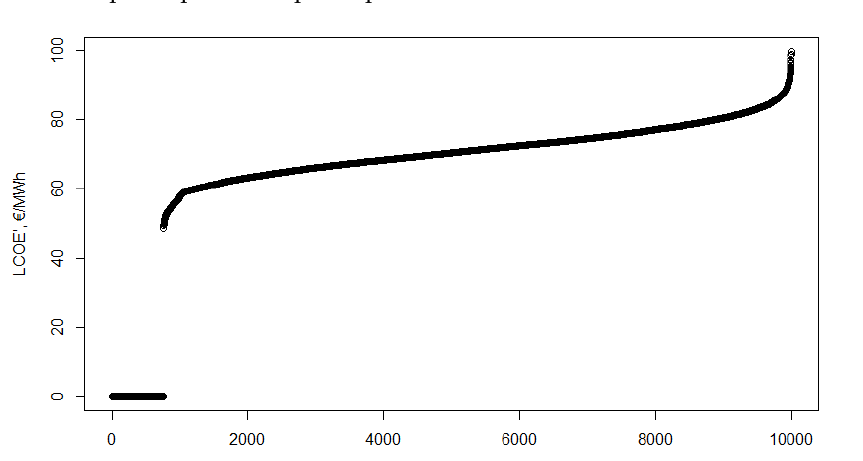
Figure 5. Empirical distribution of LCOE (cid:48) calculated from the simulated 10,000 investment costs, source: own